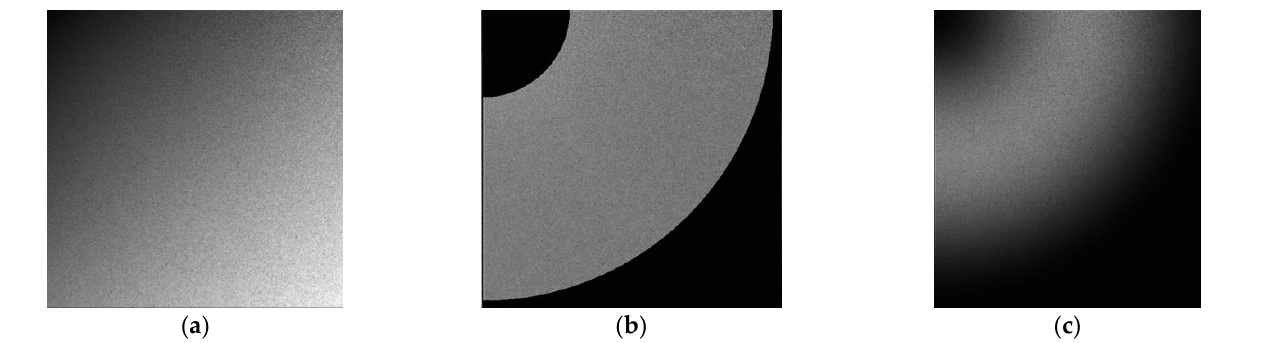
Figure 8. Graphical representation of sharpness detectors 𝑃 𝑎 (a); 𝑃 𝑏 (b); 𝑃 𝑐 (c). Taken from [26].